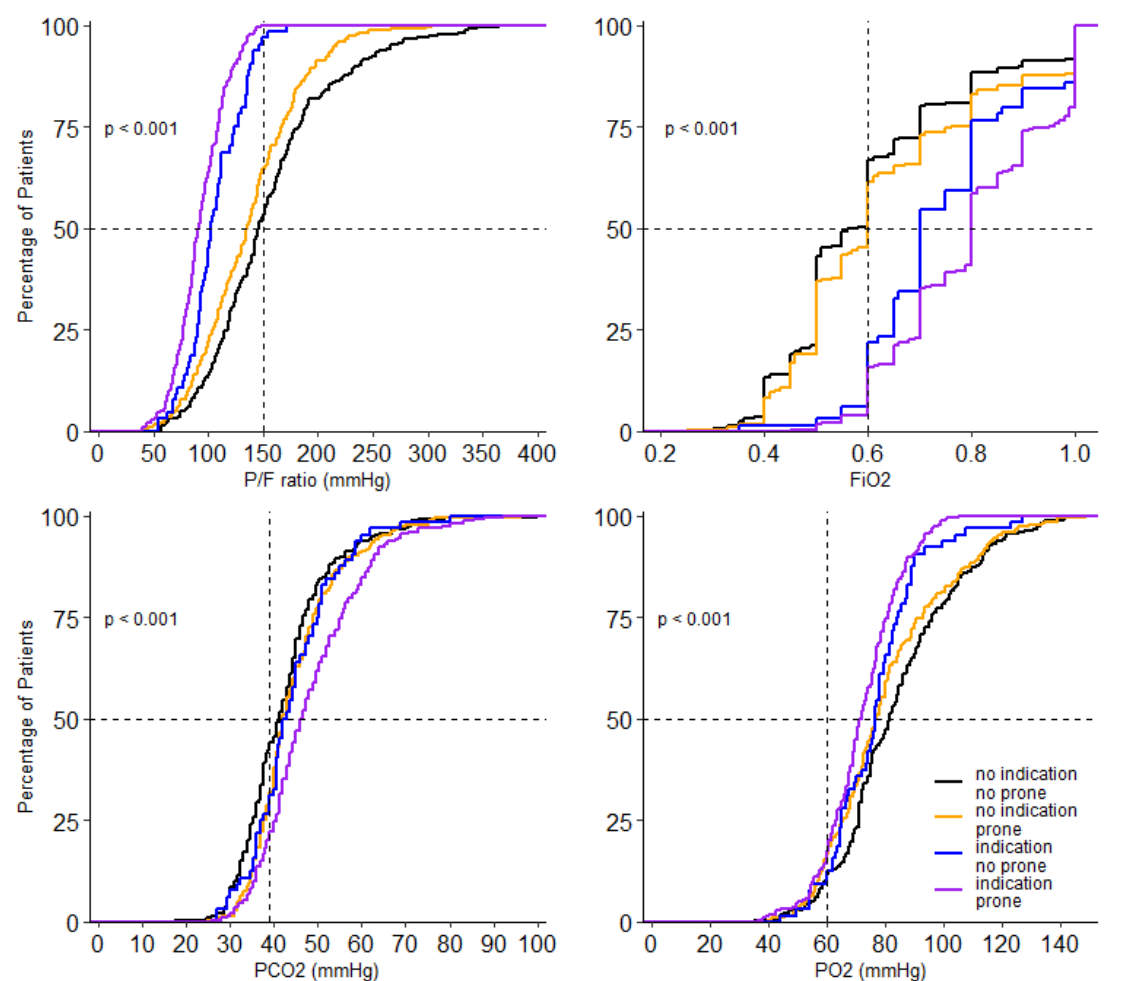
Figure 4. Cumulative distribution of parameters of gas exchange on day 0. Levels of P/F ratio FiO 2 , PO 2 and PCO 2 for each patient on day 0.